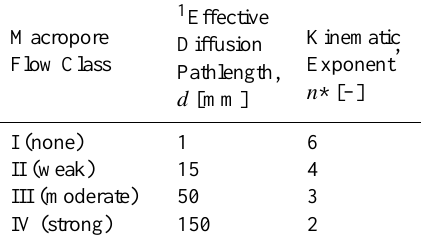
Table 3. Lookup table for estimating macroporosity in MACRO (horizon designations are FAO Master Horizon Designations).